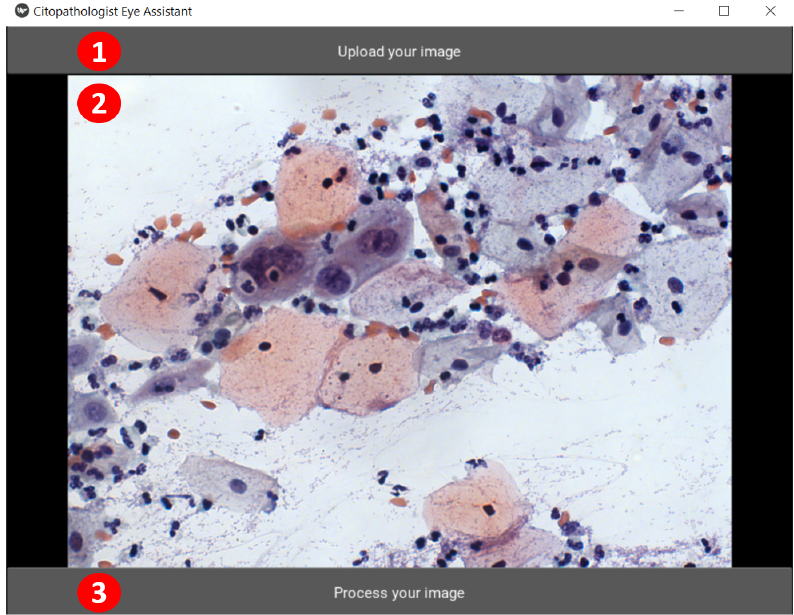
Figure 5. CEA home